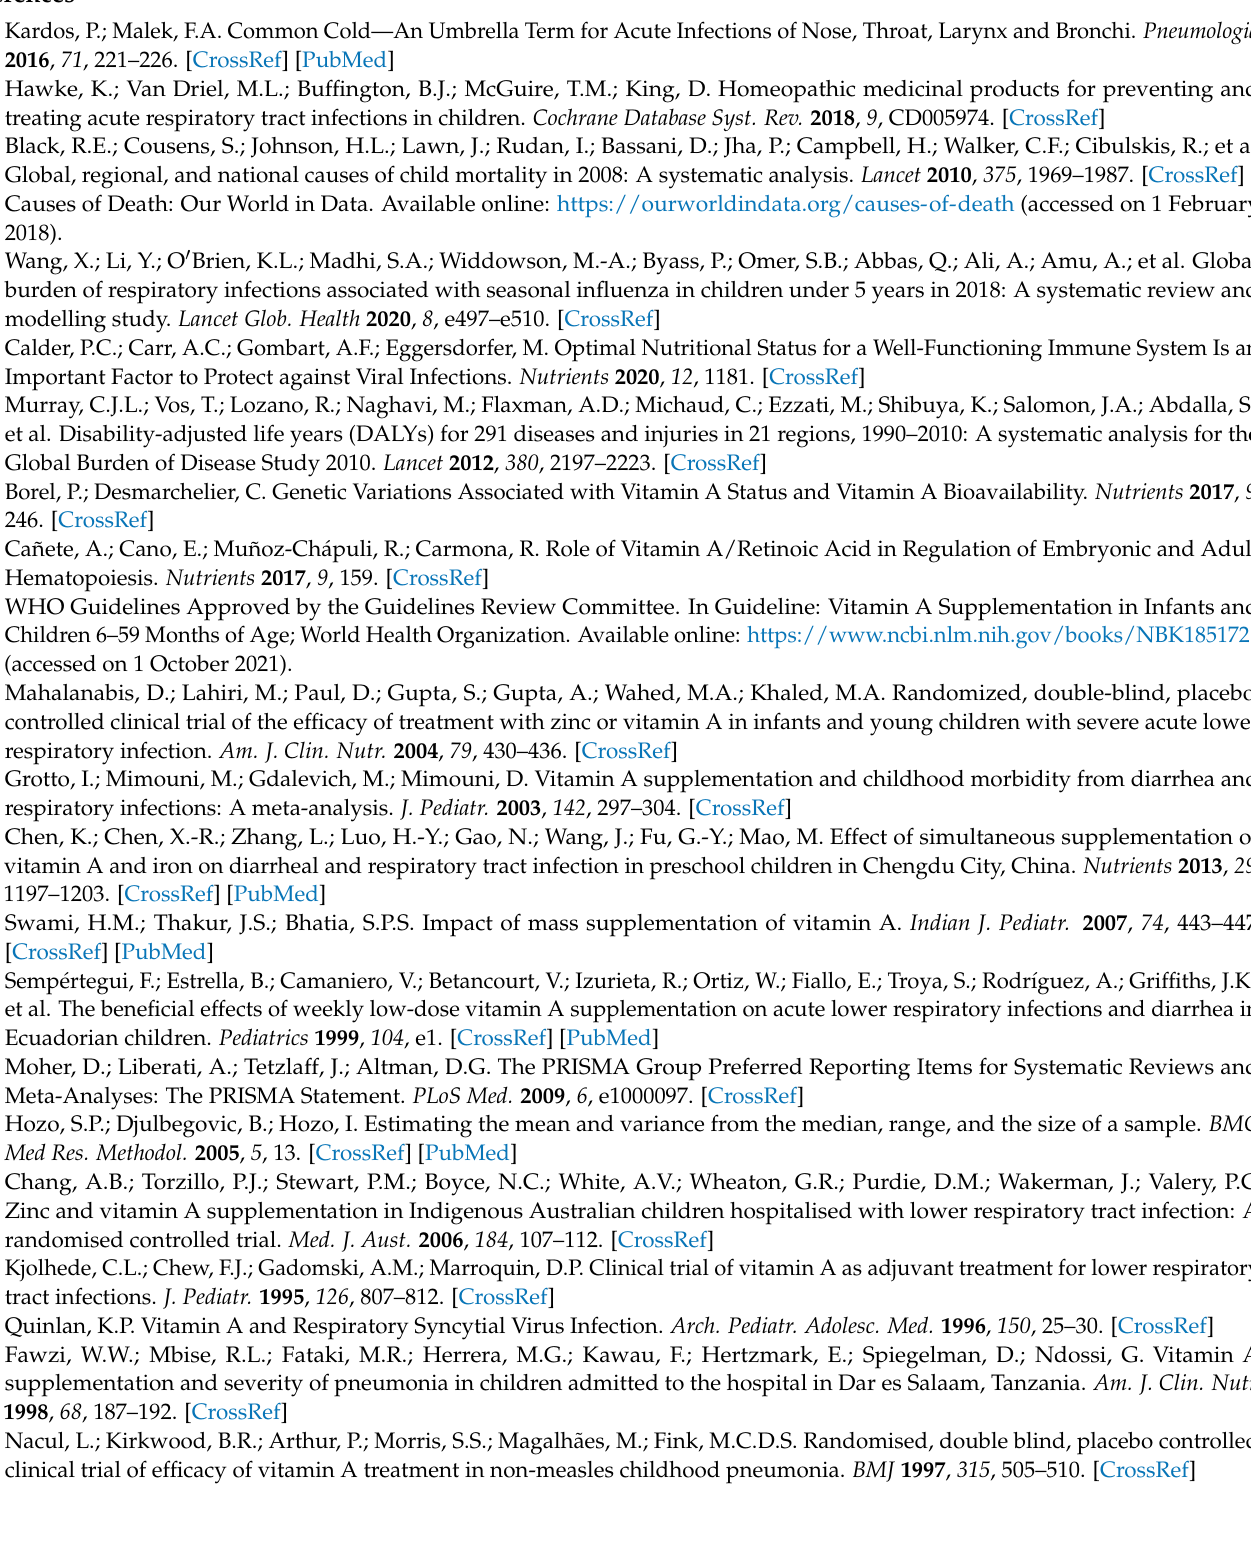
Ovid 853: ((Vitamin A) or retinol or carotene) and ((respiratory tract infection) or (acute lower respiratory infection) or (acute respiratory tract infection) or (acute upper respiratory infection) or pneumonia or tonsillitis or (Sore throat) or pharyngitis or cold or bronchitis) and (Supplement or fortified or intervention) and (trial or (double blind) or (single blind) or (controlled study) or (comparative study)).mp. [mp = title, abstract, full text, caption text] limit 1 to original